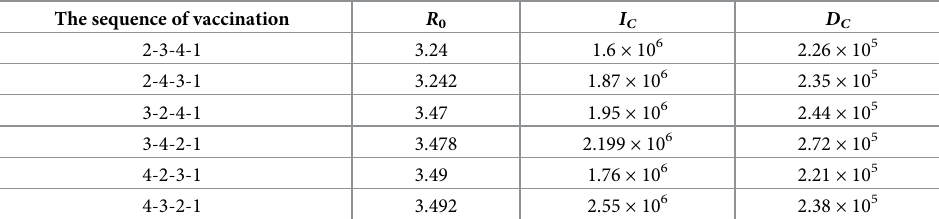
Table 7. R 0 , I C and D C were inoculated in six sequences, Brazil. The sequence of vaccination